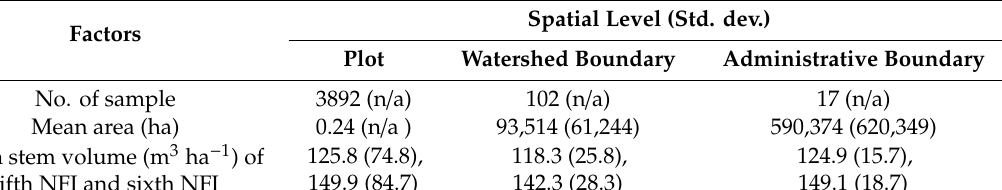
Table 2. Descriptive statistics of validation data by spatial level.